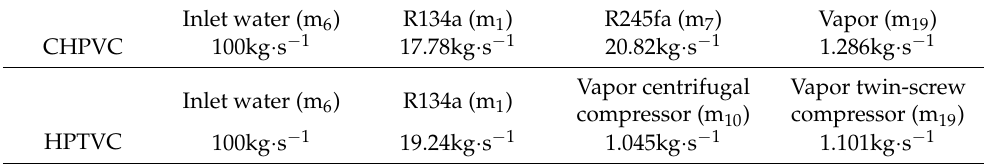
Table 3. Mass flow rate of each working fluid.